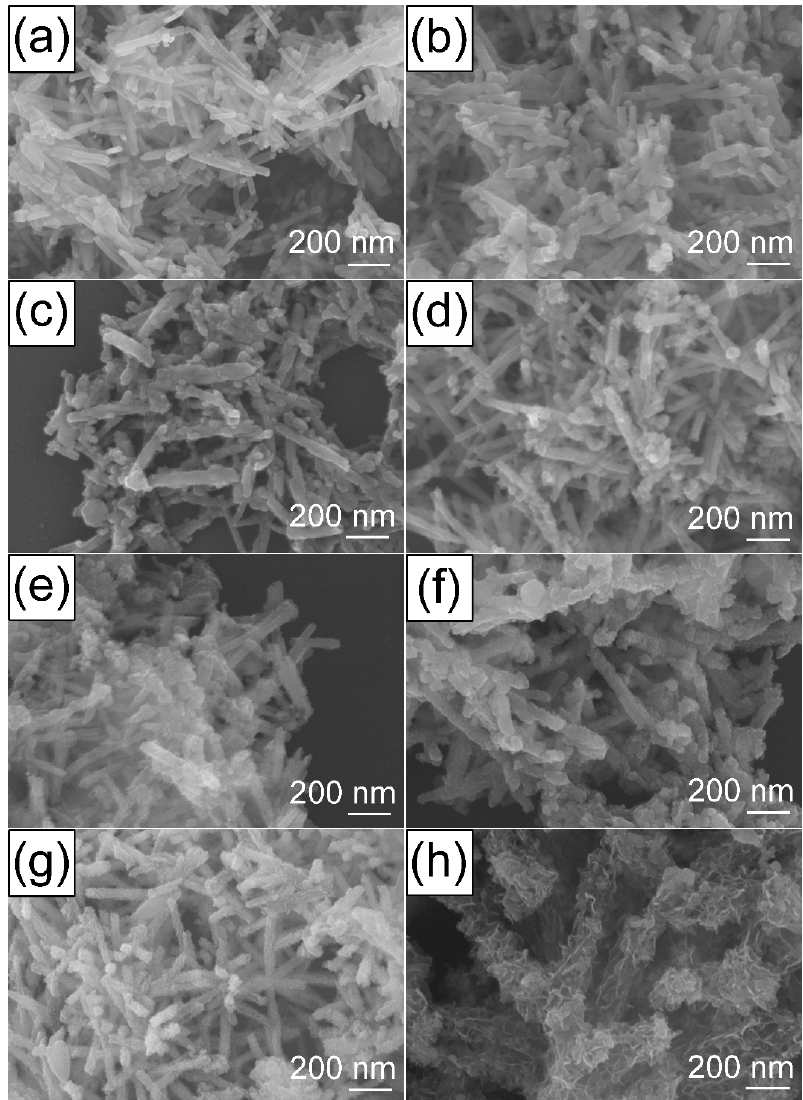
Figure 3. Scanning electron microscopy (SEM) images of Ag 4 Bi 2 O 5 /MnO 2 with different ratios of manganese dioxides contents, ( a ) 0%; ( b ) 10%; ( c ) 20%; ( d ) 30%; ( e ) 40%; ( f ) 50%; ( g ) 60%; and ( h ) 70% Mn. Catalysts 2017 , 7 , 379